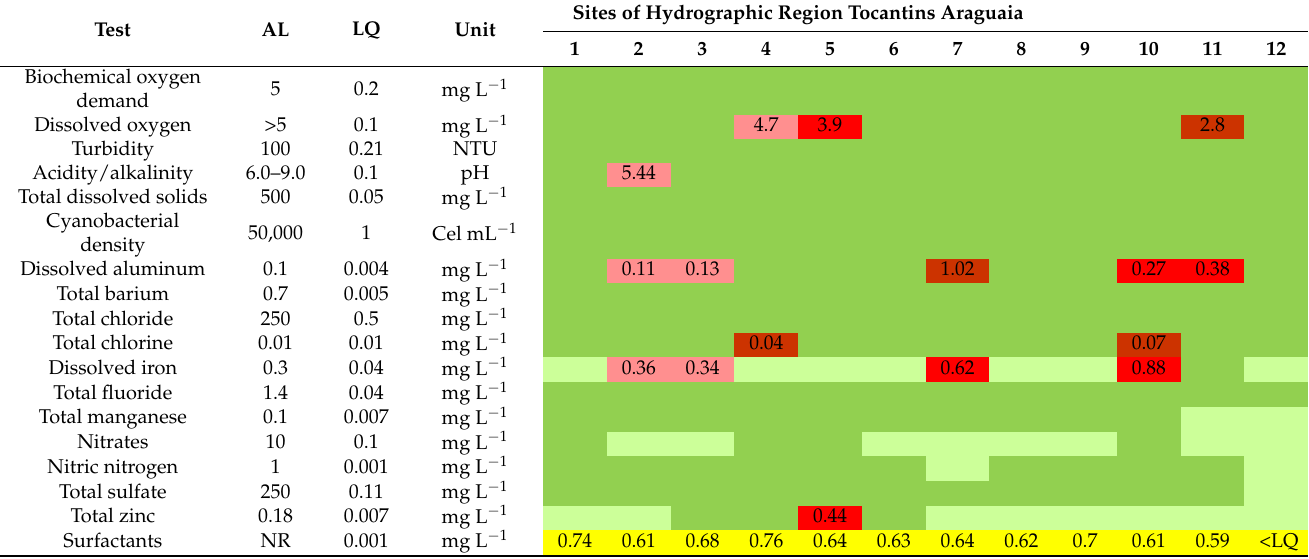
respectively, when compared to the ASTM control condition (Figure 2).